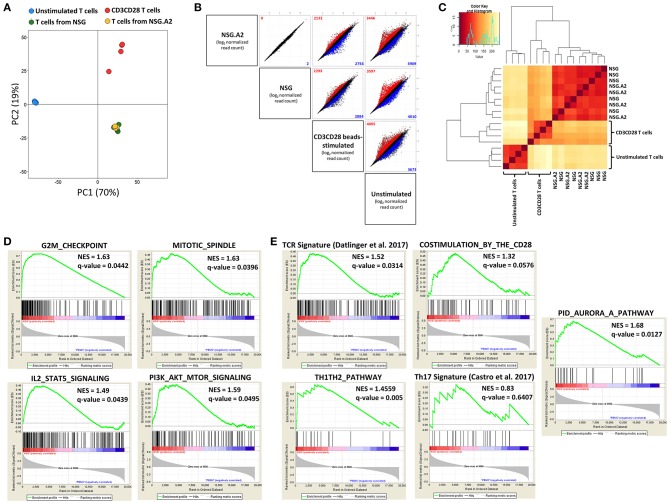
RNA sequencing of T cells isolated from spleen of NSG and NSG-HLA-A2/HHD mice. RNA-sequencing was performed on T cells sorted from the spleen of NSG and NSG-HLA-A2/HHD (NSG.A2 in figure) mice at day 7 post-transplantation, as well as on unstimulated T cells and CD3/CD28-stimulated T cells (n = 4–5 in each condition). (A) Principal-component analysis performed using all genes having at least one read in at least one sample. (B) Gene expression (average of log2 normalized read counts) in every pairwise comparison between the different conditions. Colors indicate significant (FDR ≤ 0.05) upregulation (of at least 2-fold; red) or downregulation (of at least 0.5-fold; blue) of expression in the comparison of the condition represented on the left vs. the condition represented on the bottom of the panel. Numbers in plots indicate total genes upregulated (red) or downregulated (blue). (C) Heatmap of hierarchical clustering of the different samples. (D) Gene set enrichment analyzes (GSEA) of the NSG vs. unstimulated T cells comparison. (E) GSEA of the NSG vs. unstimulated T cells comparison for TCR signaling, costimulation, Th1Th2 differentiation, Th17 differentiation by the RORγt and RORα signature genes set and Aurora kinase A pathway comparisons.